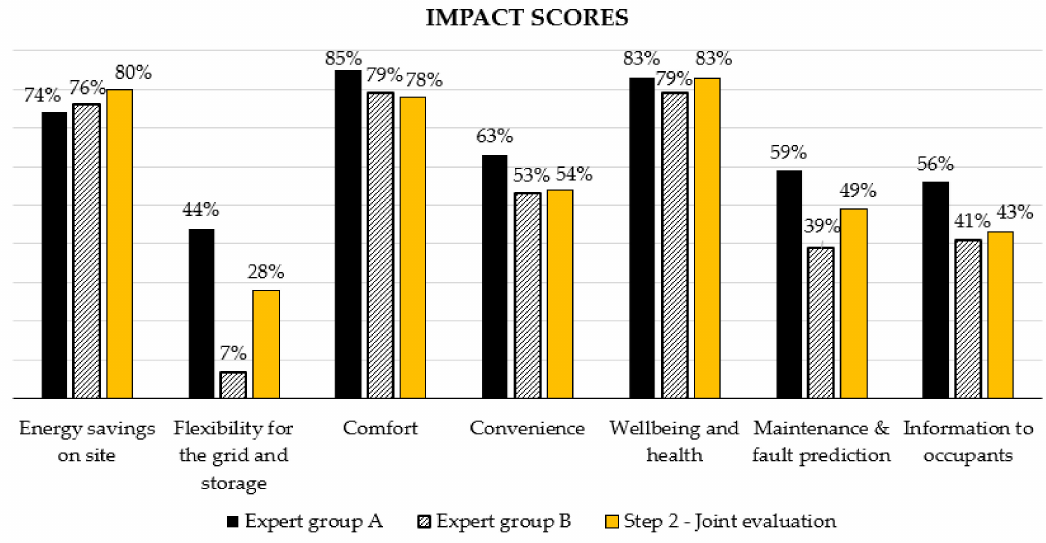
Figure 3. Impact scores. Results of the of the independent assessment of the expert group A (black bars), of the independent assessment of expert group B (dashed bars) and of the joint assessment of the two expert groups (yellow